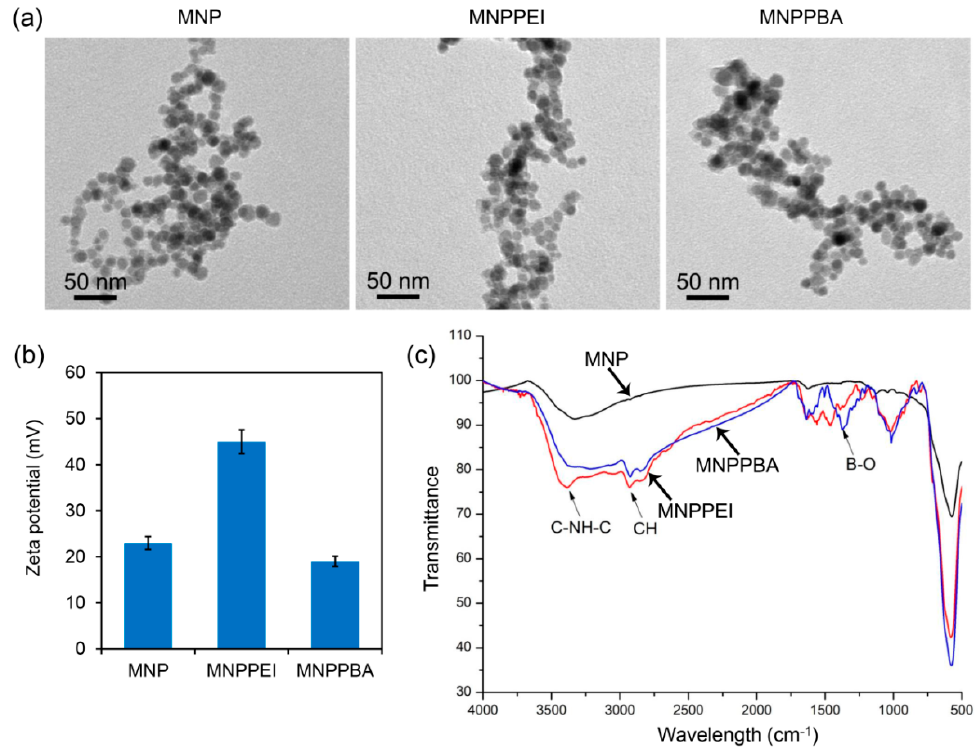
Figure 2. Characterization of MNP, MNPPEI and MNPPBA. ( a ) TEM images of the synthesized nanoparticles. ( b ) Zeta potentials of the nanoparticles. ( c ) FT-IR spectra of the nanoparticles.